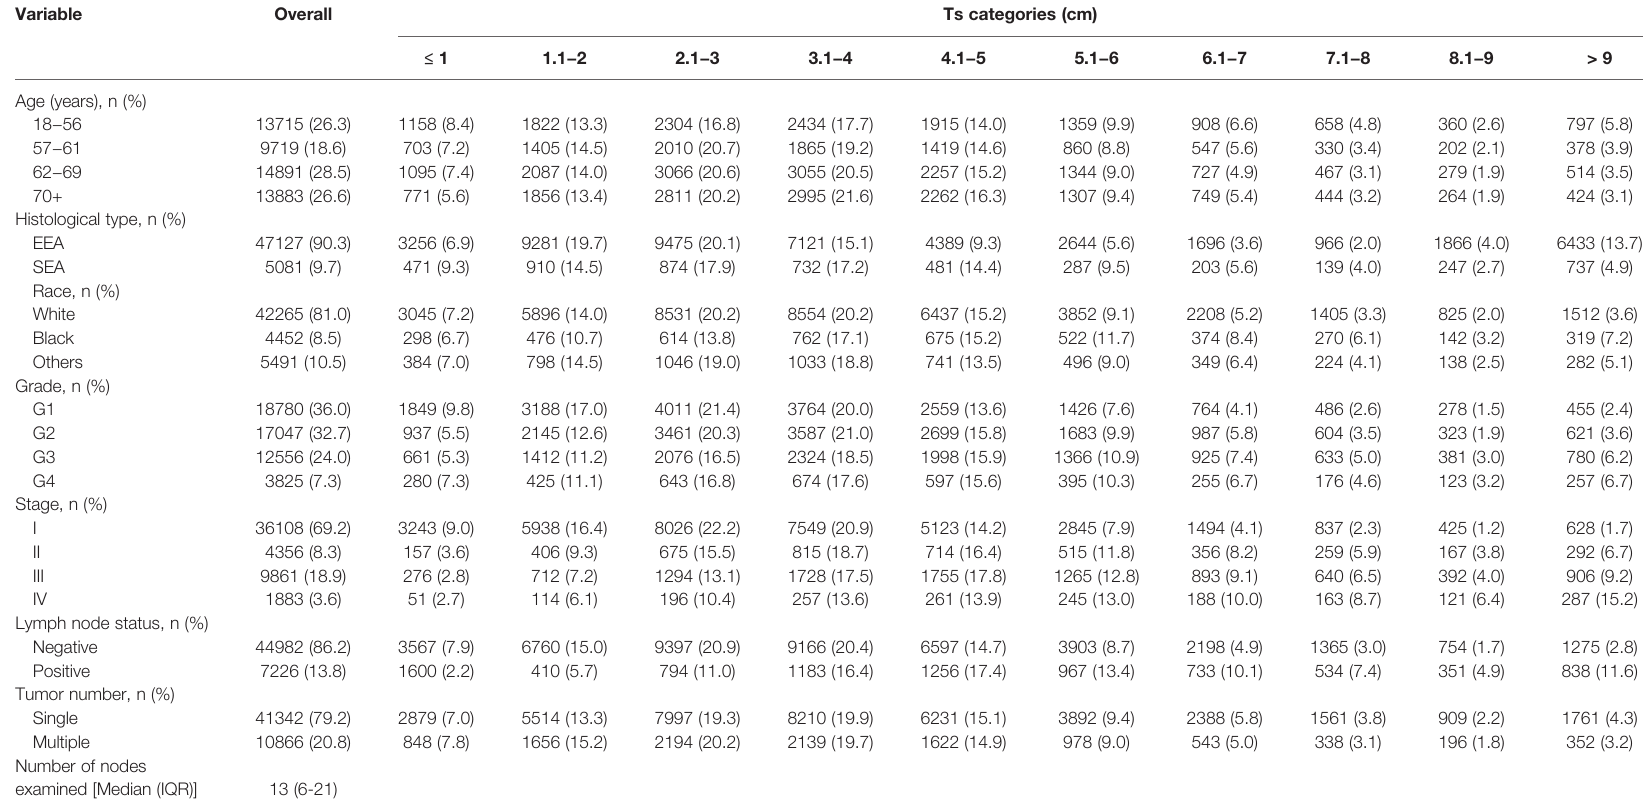
TABLE 1 | Baseline characteristics of patients with endometrial cancer according to tumor size